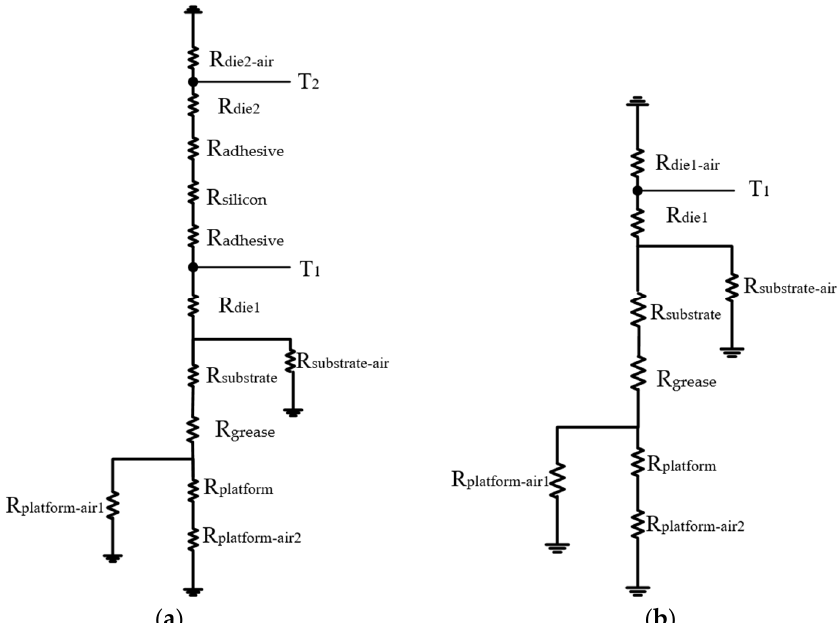
Figure 6. Thermal resistance network model of the single-layer and double-layer GaN MISHEMTs. (a) Double-layer device thermal resistance network, (b) Single-layer device thermal resistance net- work.